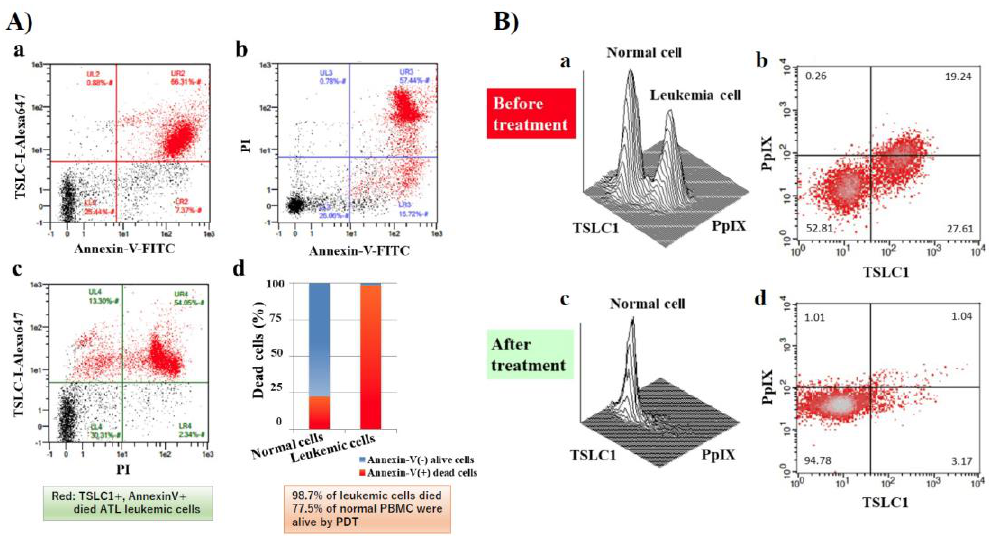
Figure 3. FCM analyses of chronic ATL patient PBMCs before and after photodynamic therapy (PDT). After PDT treatment, cells were labeled with PI, tumor suppressor in lung cancer 1 (TSLC1)-Alexa647, and Annexin V-FITC and analyzed. ( A ) (d) FCM analyses showed that 98.7% of TSLC1(+) ATL leukemic cells were TSLC1( + ) / Annexin V( + ) dead cells (red), whereas 77.5% of TSLC1(-) normal cells were TSLC1(-) / Annexin V(-) live cells (blue) after aminolevulinic acid (ALA)-PDT treatment, indicating that ALA-PDT induced highly-specific ATL leukemia cell death with minimal damage to normal PBMCs. FCM analyses of chronic ATL patient specimens before and after ALA-PDT treatment. ( B ) (a,b) Chronic ATL PBMCs incubated in 1 mM 5ALA for 48 h showing 2 peaks corresponding to the normal and ATL leukemic cells in TSLC1-FITC and PpIX profiles. (c,d) After 10 min of light exposure-treatment, the ATL leukemic cell peak completely disappeared and only the normal cell peak remained. This figure is reproduced, modified from Figures 5 and 6 in Oka et al. ( Scientific Reports 2018) [59] Reprint is permitted by Scientific Reports .